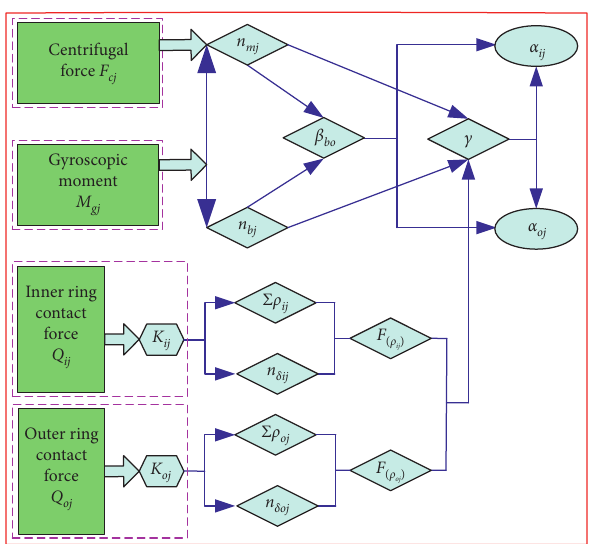
Figure 8: Dynamic characteristic equations variable transfer re- lationship total analysis